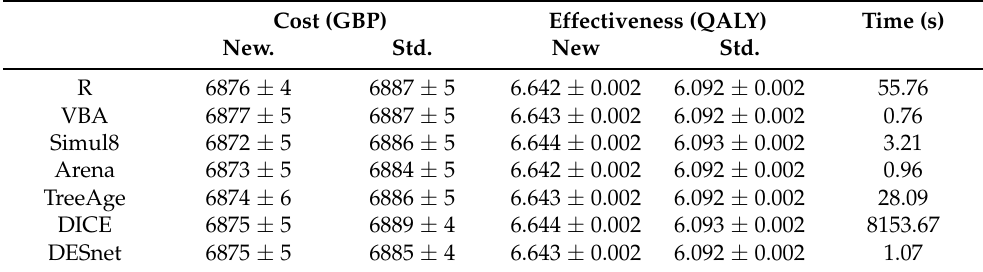
Table 1. Average results (95% CI) for experiments simulating 25 series, each with 50,000 patients, in the osteoporosis model. The table shows the cost and the effectiveness for the standard treatment (std.) and the new one. QALY = quality-adjusted life year. DESnet is implemented as an OpenMarkov plug-in and DICE as an Excel plug-in. Cost (GBP)